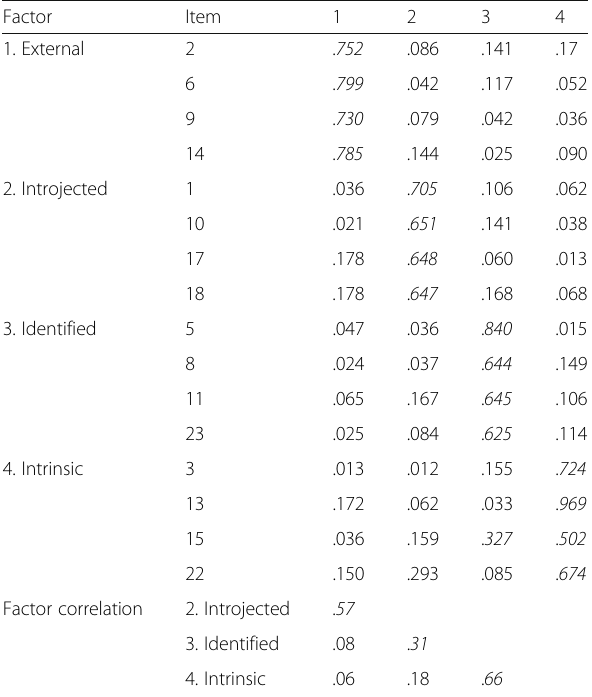
Table 2 Factor loadings and correlations for the four-factor model re-specified (16